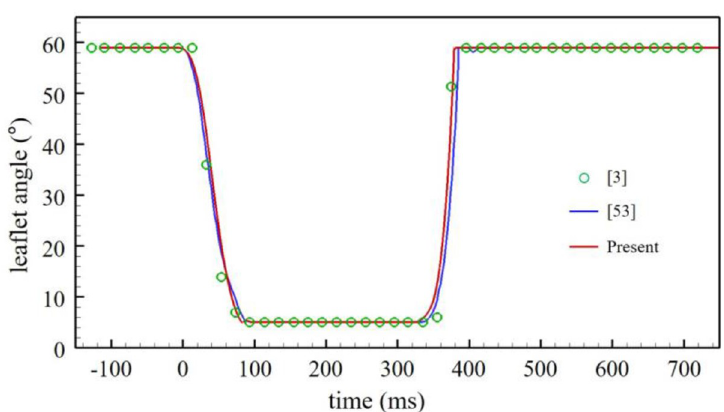
Fig 3. Time history of the leaflet angle during one cycle obtained from the present study, in comparison with those from previous numerical [53] and experimental [3] studies.